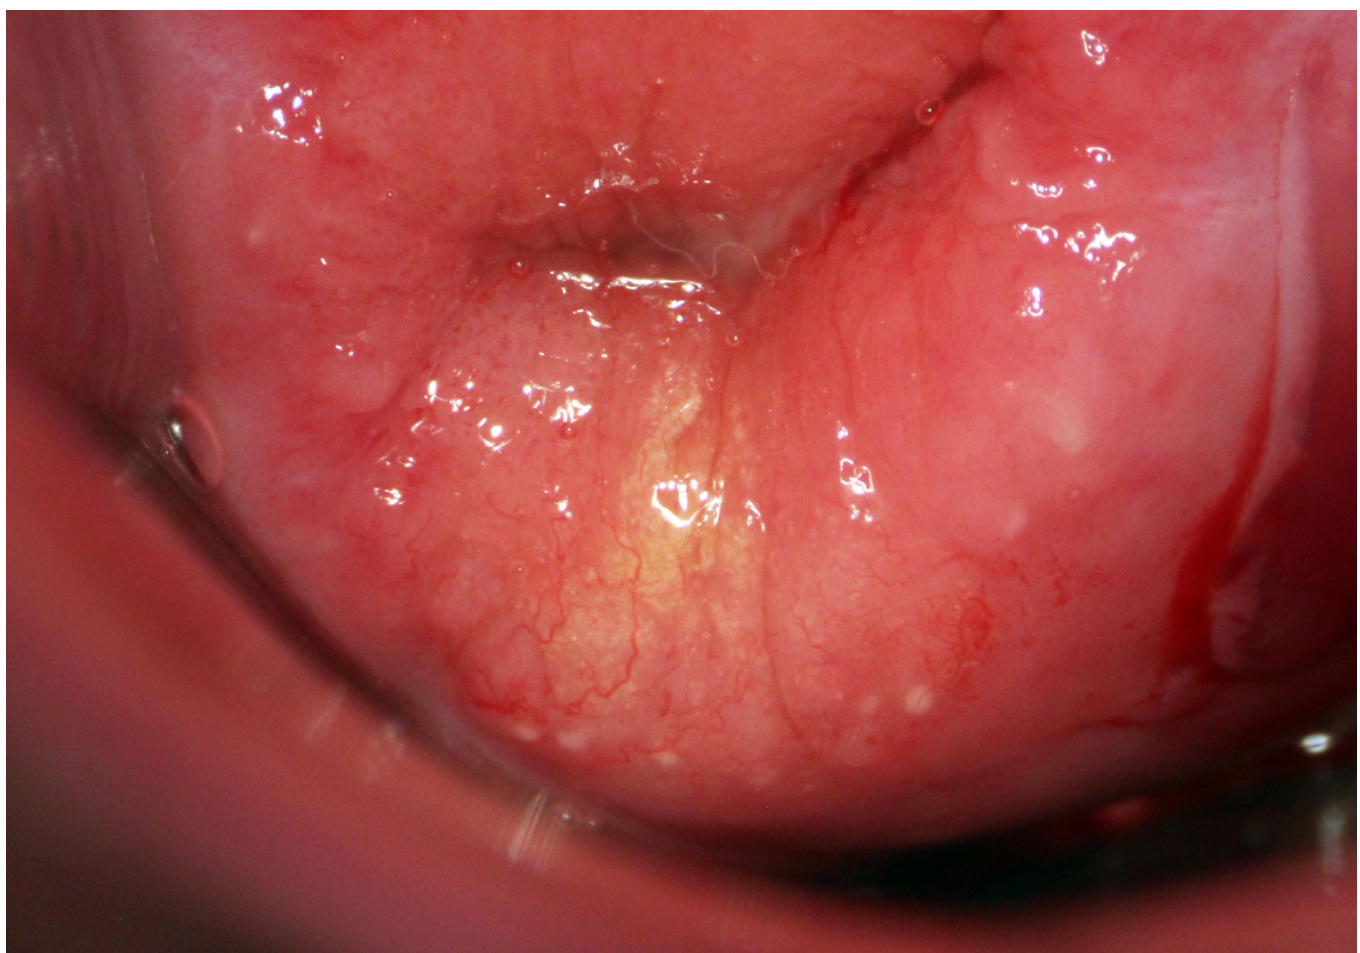
Fig 1. Sandy patch on the cervix. Colposcopic image of the ectocervix showing a grainy sandy patch at 6 o ’ clock. In addition there are many scattered grains in a sector from 4 o ’ clock to 7 o ’ clock. Abnormal blood vessels can also be seen on the mucosa, many near and between the schistosome grains.